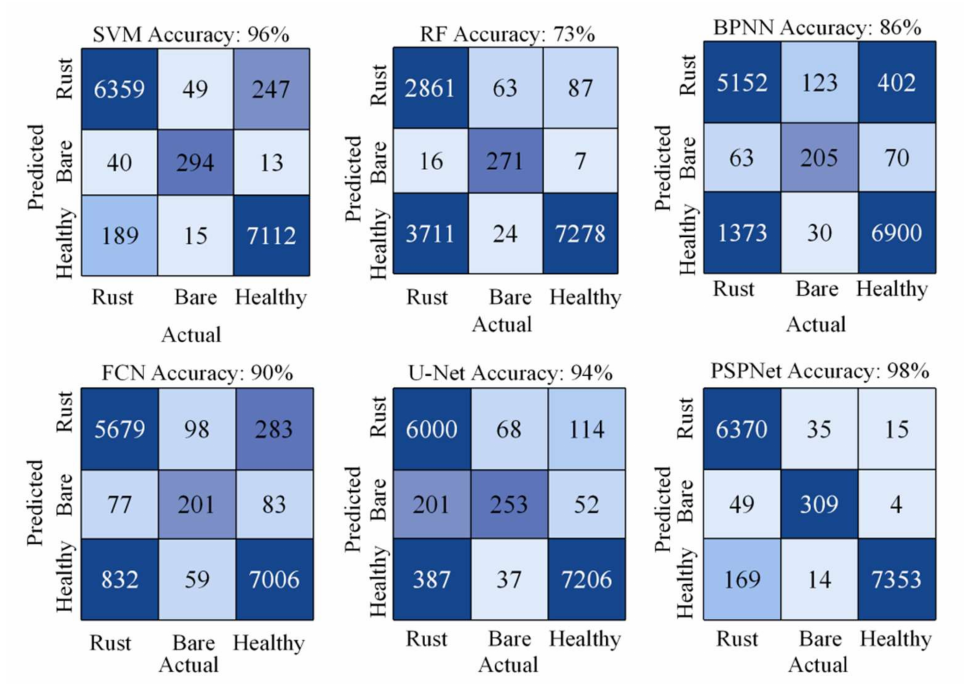
Figure 5. Classification accuracy and confusion matrix of the SVM, RF, BPNN, FCN, U-Net, and PSPNet